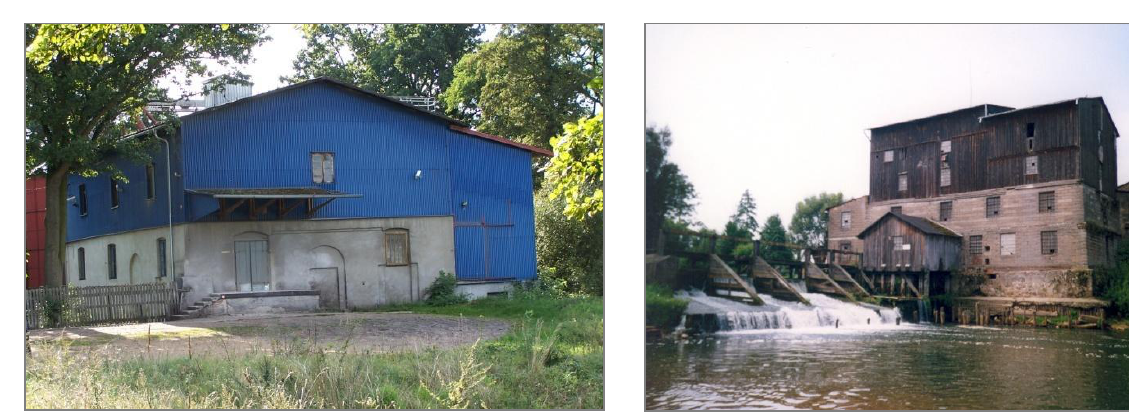
Fig. 2. Historic mill in Kuźnica Stara on the River Pankówka ( M. Fajer )